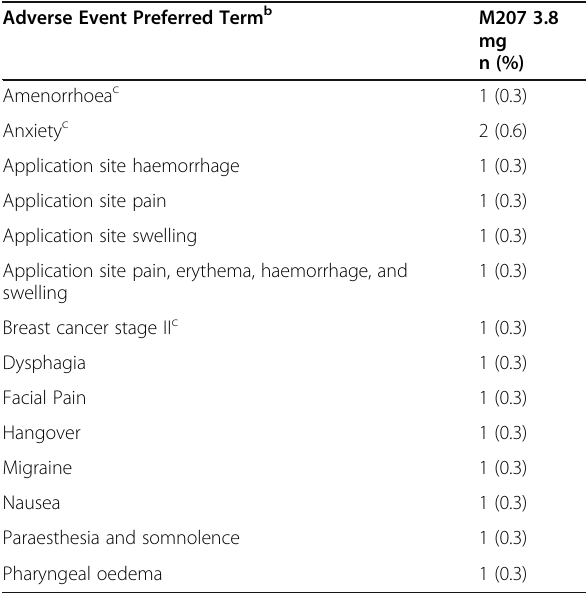
Table 2 Number of Participants with Treatment Emergent Adverse Events a leading to Study Drug Withdrawal (Safety Population, N = 335)